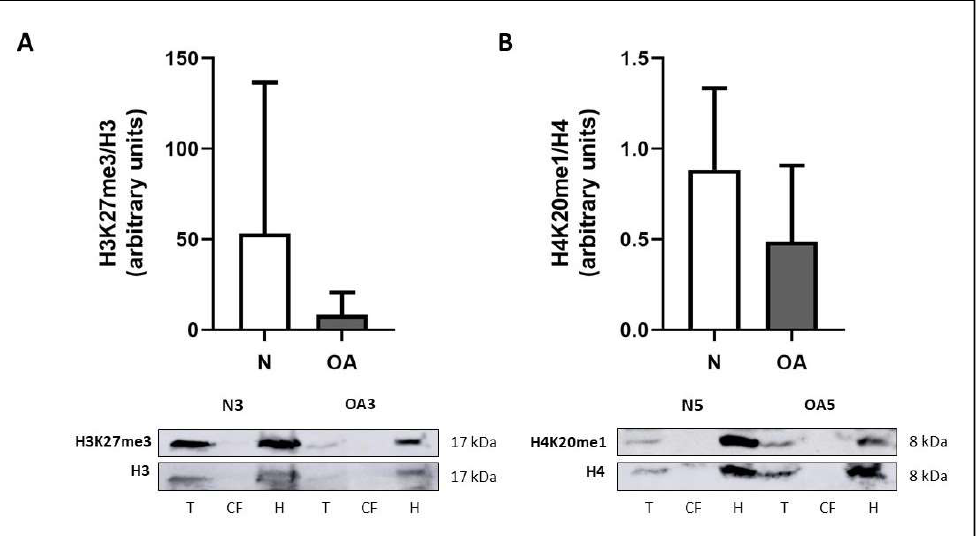
Figure 4. Comparison of histone marks H3K27me3 and H4K20me1 in OA and N cartilage by Western blotting. Proteins from total extract (T), cytosolic fraction (CF) and histone extract (H) were loaded. Ten micrograms of protein were loaded in each lane. ( A ) H3K27me3 (#9733, Cell Signaling Technology, 1:1000) expression relative to H3 (#14269, Cell Signaling Technology, 1:10 , 000) in OA and N cartilage. ( B ) H4K20me1 (39027, Active Motif, 1:1000) expression relative to H4 (61521, Active Motif, 1:10 , 000) in OA and N cartilage. Secondary antibody Rabbit IgG HRP Linked Whole Ab (NA934, 1:2000) and Mouse IgG HRP Linked Whole Ab (NA931, 1:2500) were used.